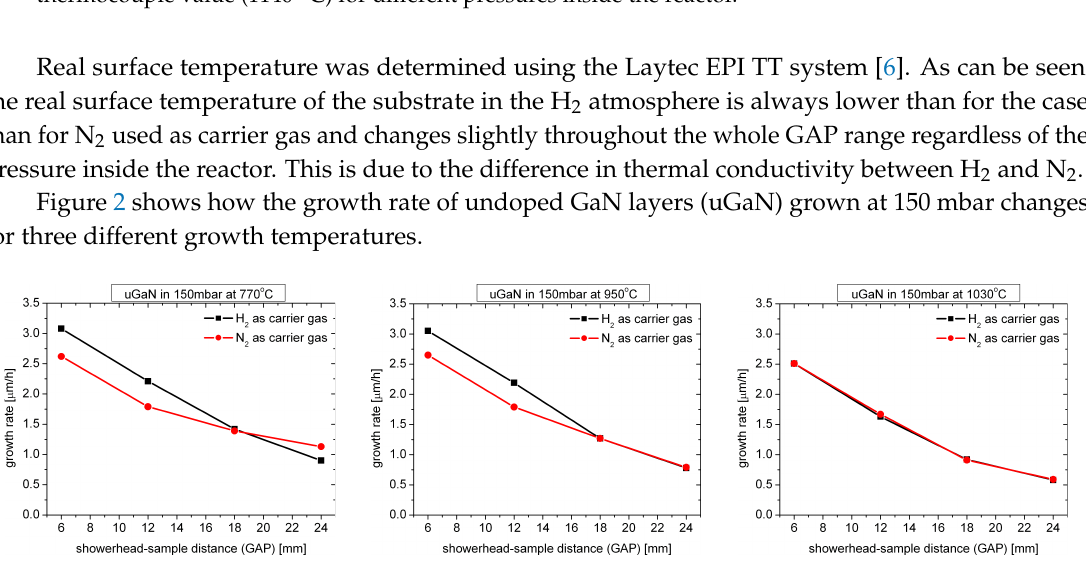
Figure 1. Surface temperature as a showerhead-sample distance (GAP) function for a fixed thermocouple value (1140 ◦ C) for different pressures inside the reactor.